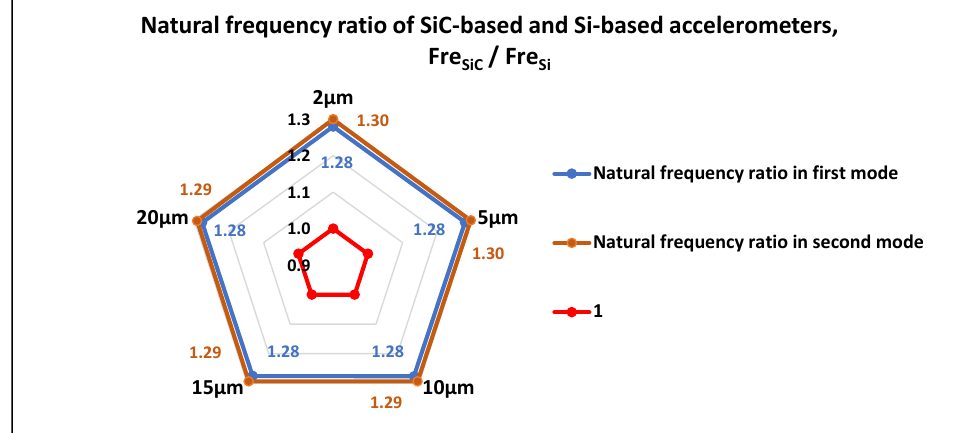
Figure 6. Comparison between the natural frequencies of the SiC-based accelerometer and Si-based accelerometer with the same structure.